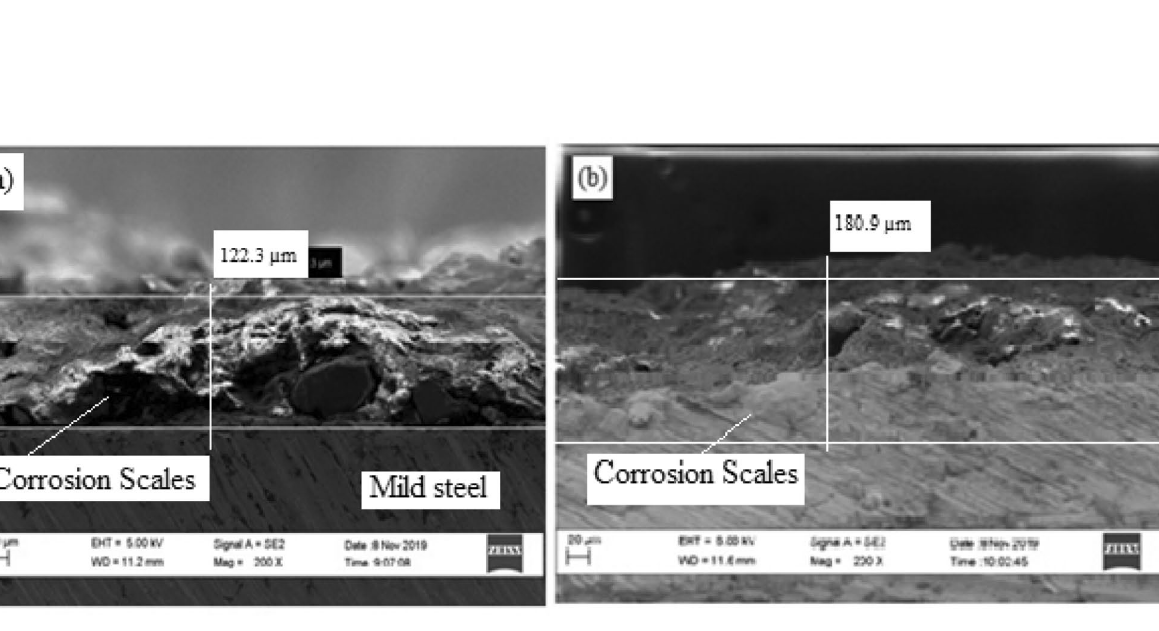
Figure 16. SEM cross-sectional view of the sample coated and heated at 300 °C ( a ) before corrosion and ( b ) after